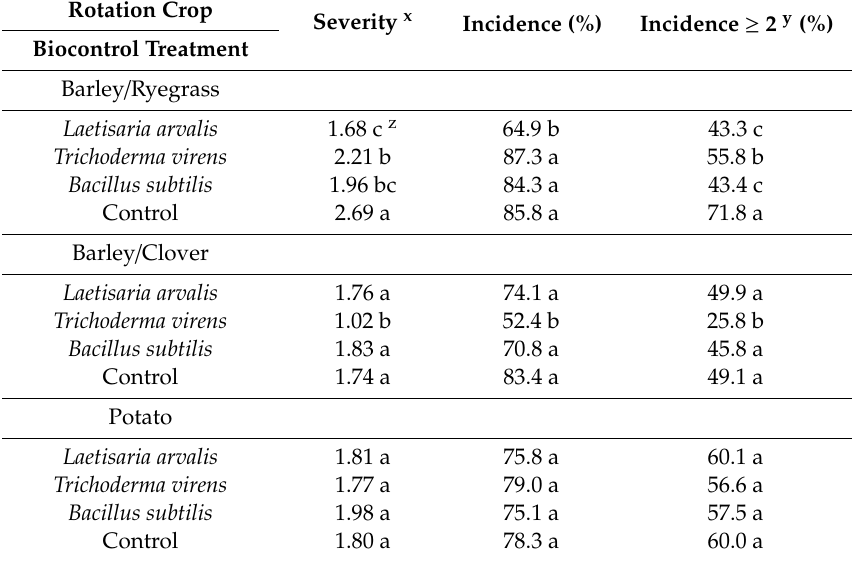
Table 3. Black scurf ratings for biocontrol treatments as a ff ected by preceding rotation crop at location 1 (Central Maine).